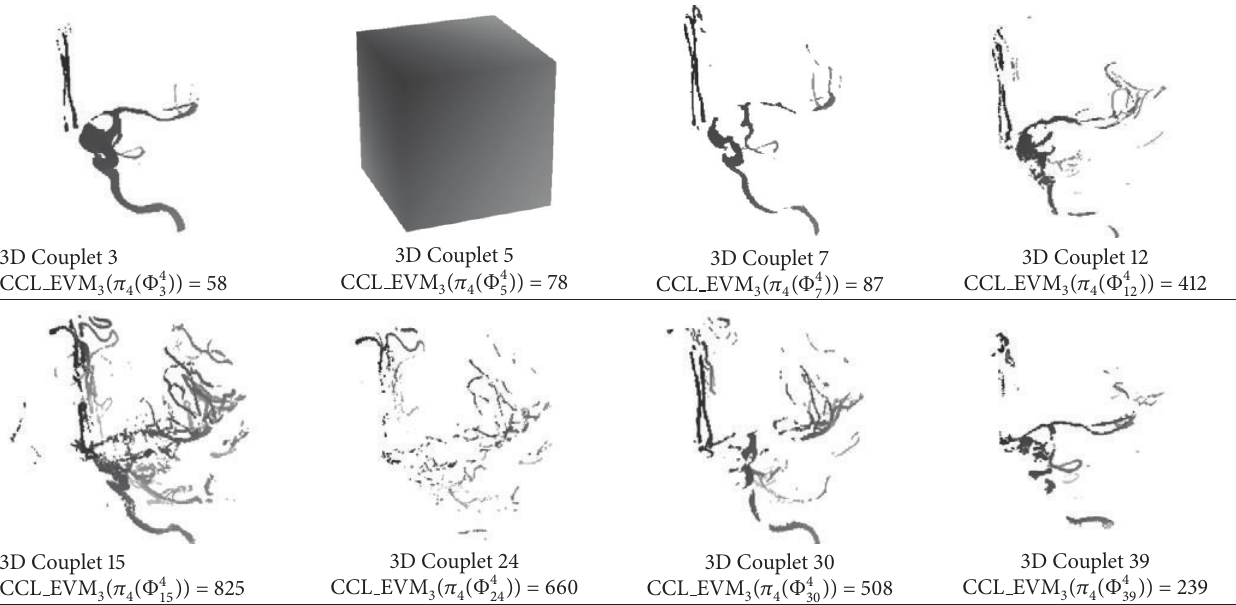
Table 10: Some 3D couplets, perpendicular to color axis, extracted from the 4D-EVM produced by means of Framework n D-EVM/Kohonen and associated to dataset Aneurism .